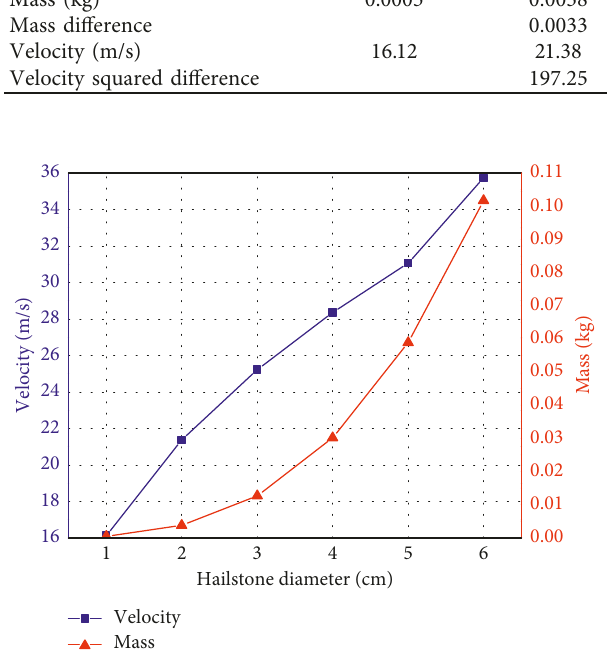
Figure 2: Mass and velocity of hailstone in different